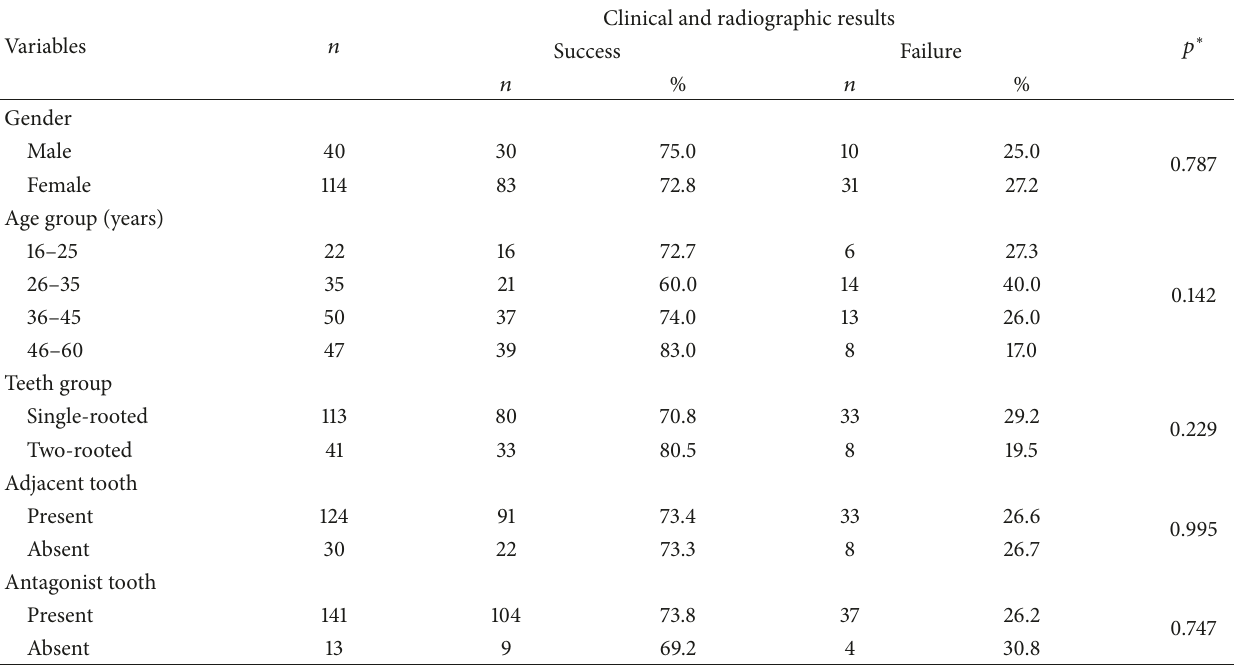
Table 1: Clinical and radiographic success according to demographic